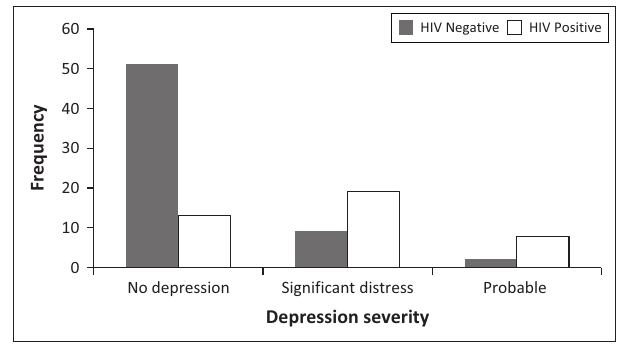
FIGURE 1: Prevalence of depressive symptoms amongst 102 newly diagnosed HIV-infected and HIV-uninfected pregnant women in KZN, South Africa. No depression: EDS scores of 0–9; significant distress: EDS scores of 10–12; probable depression: EDS scores of